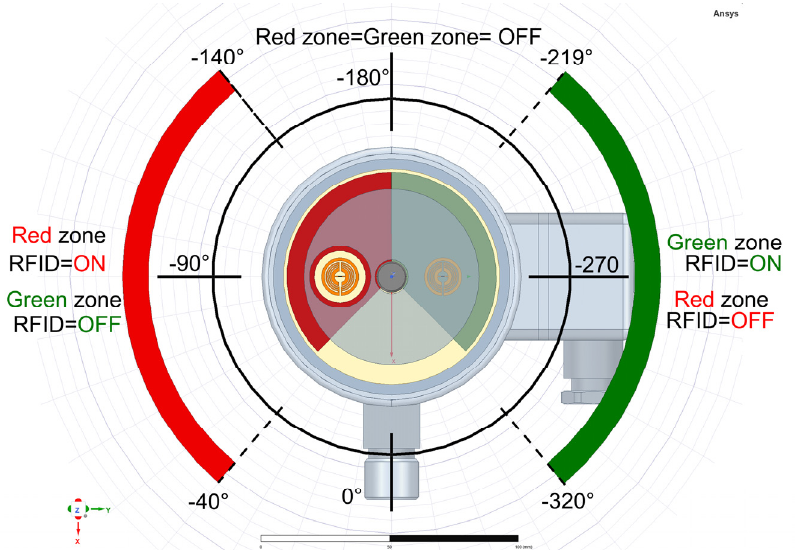
Figure 11. Digitized Analog manometer.